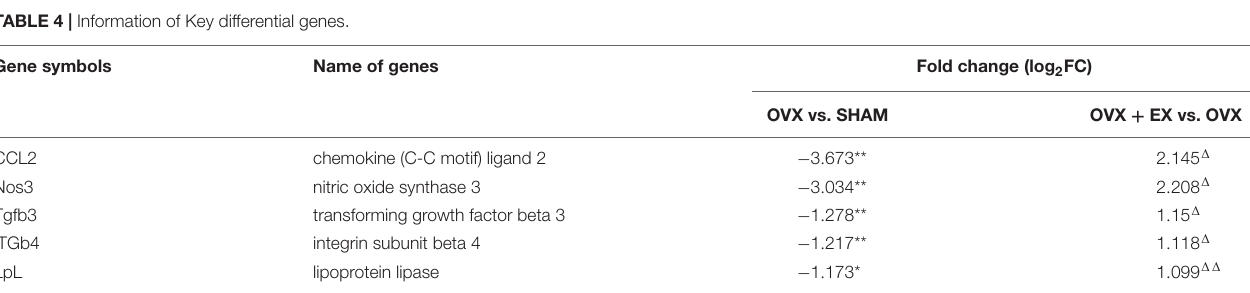
TABLE 4 | Information of Key differential genes.